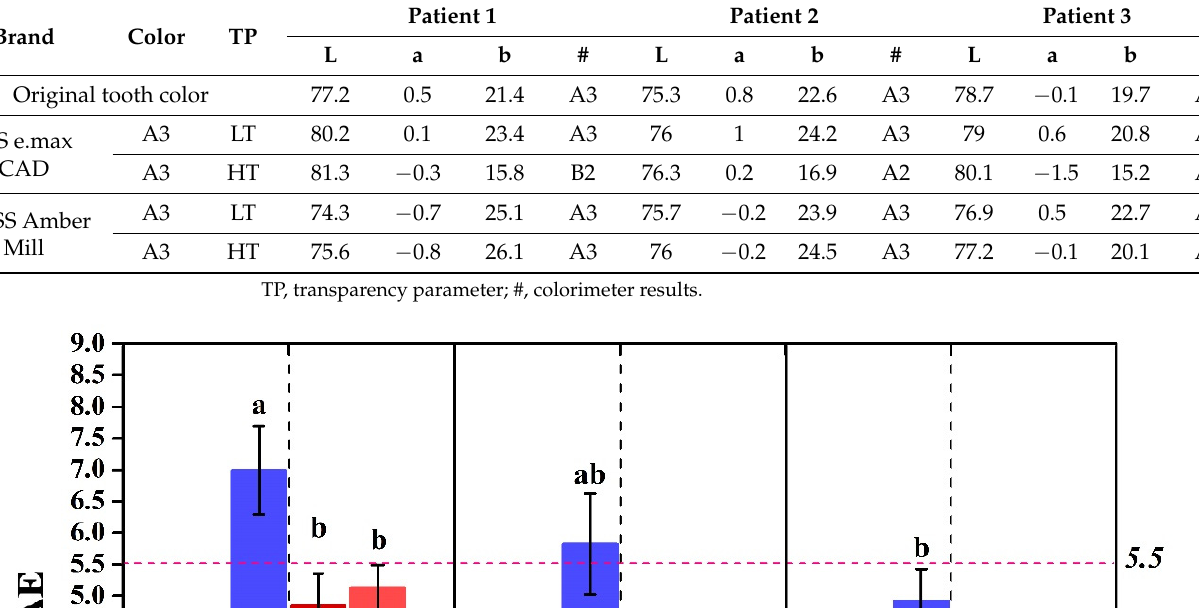
Table 2. Optical properties of A3 color glass-ceramics placed in the human oral cavity.